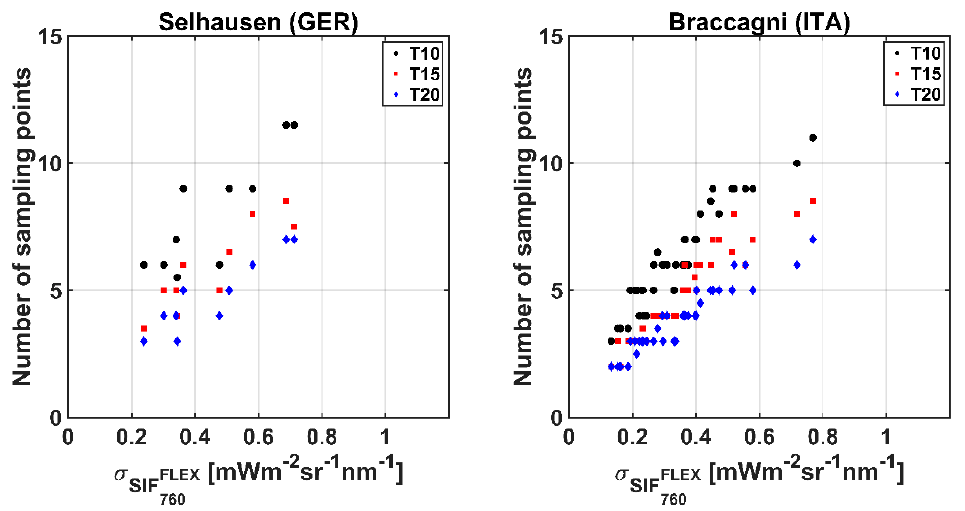
Figure 4. The 95th percentile of the number of sampling points needed to meet the thresholds for the FLEX pixels in Selhausen (Germany) and Braccagni (Italy) experimental sites using a random sampling approach.